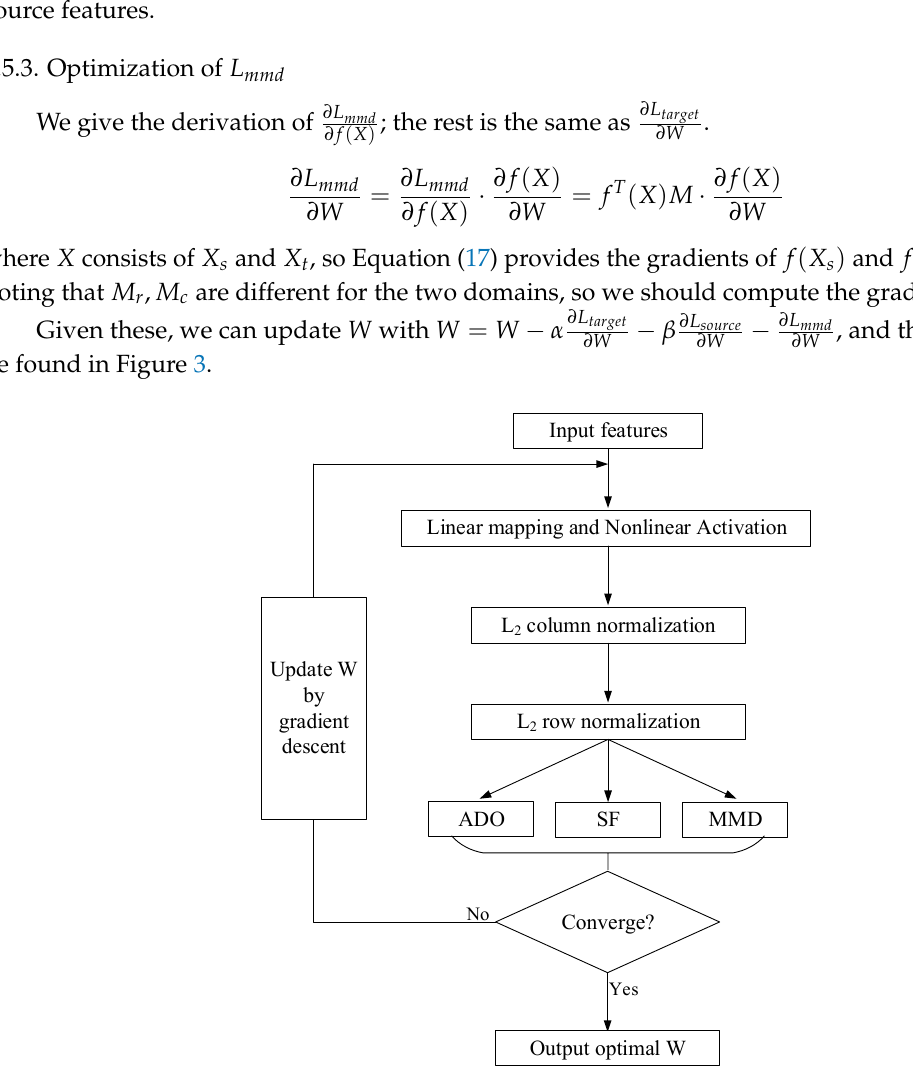
Figure 3. Flowchart of the proposed